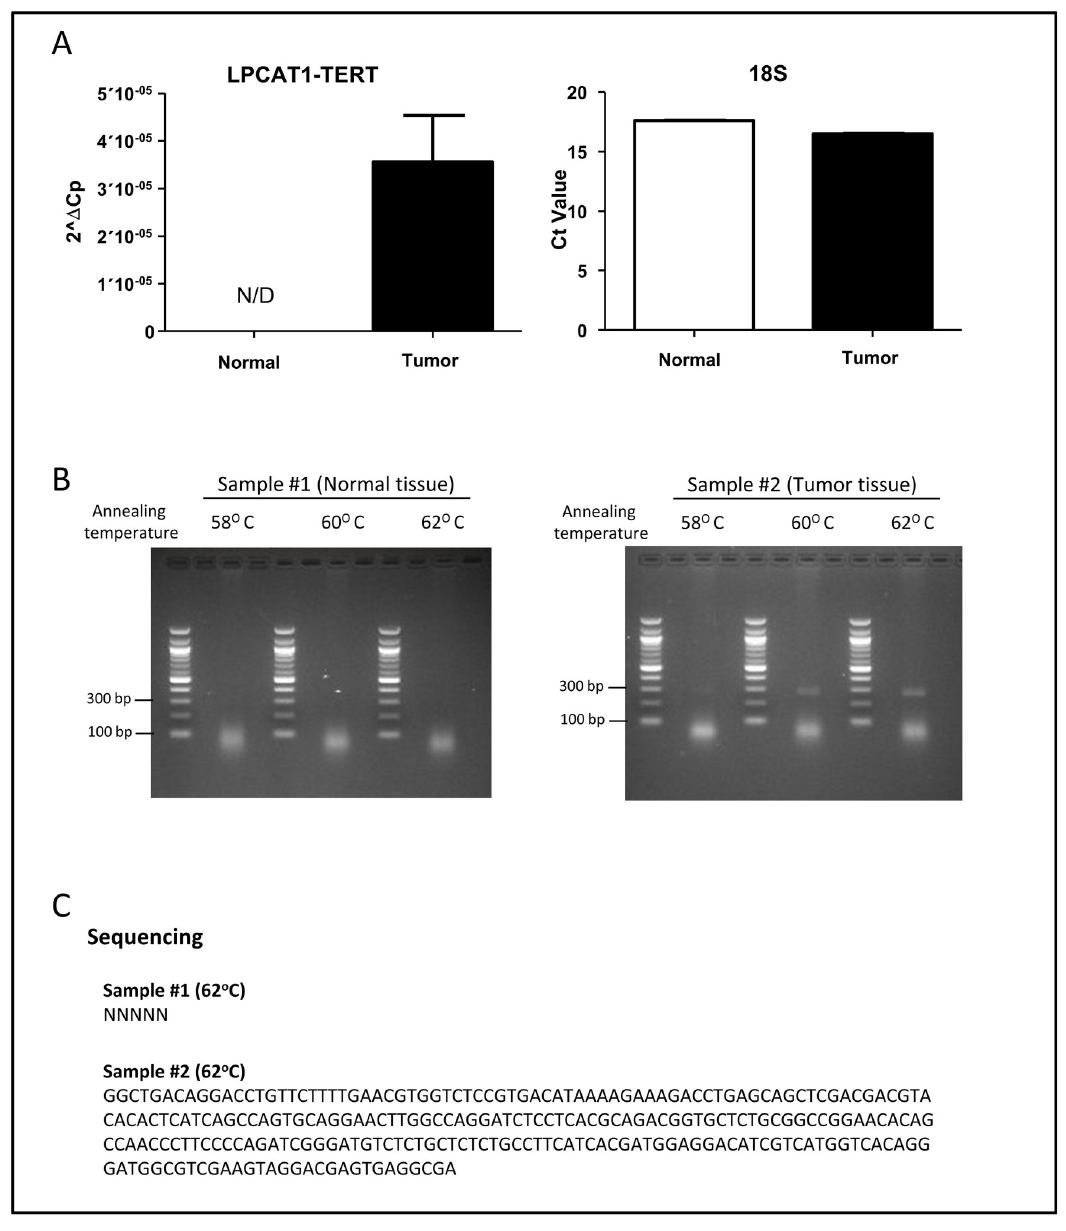
Fig 4. Confirmed expression of LCPAT1-TERT fusion transcript in ETT-1 primary tumor and absence from adjacent normal tissue. A) Real-time PCR quantification of the fusion in normal and tumor tissues in adjacent normal and primary tumor tissue utilizing an 18S RNA control. B) Gel electrophoresis of the PCR product from the tumor tissue. C) Sanger sequencing result for the PCR product produces a chimeric LPCAT1-TERT transcript. The originally tested sample for case ETT-1 was a liver metastasis occurring at relapse 3 years post-surgery and treatment. Confirmation of the fusion transcript in the primary tumor indicates that LPCAT1-TERT formation was an early event in the disease